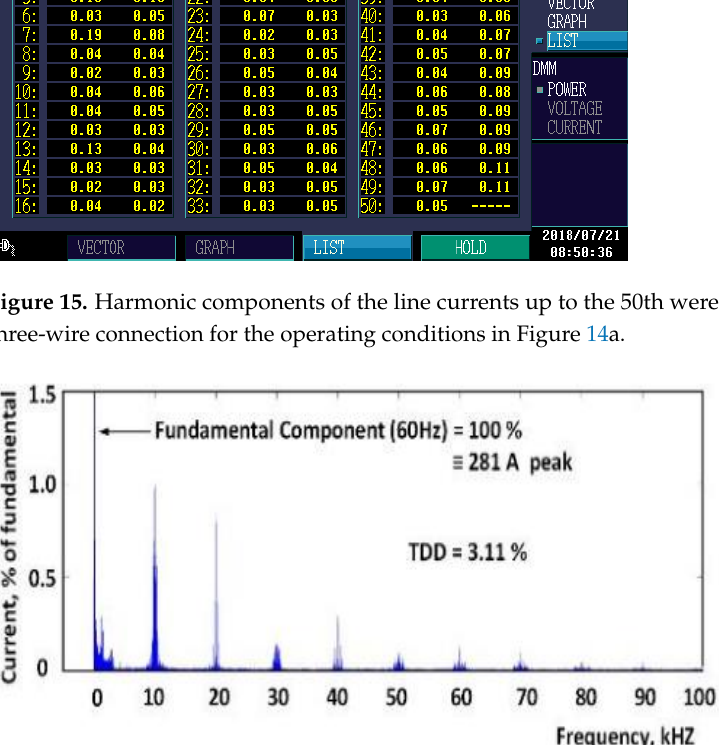
Figure 16. Fourier series expansion of recorded i A (t) waveform in Figure 14a obtained from MATLAB/Simulink FFT toolbox.